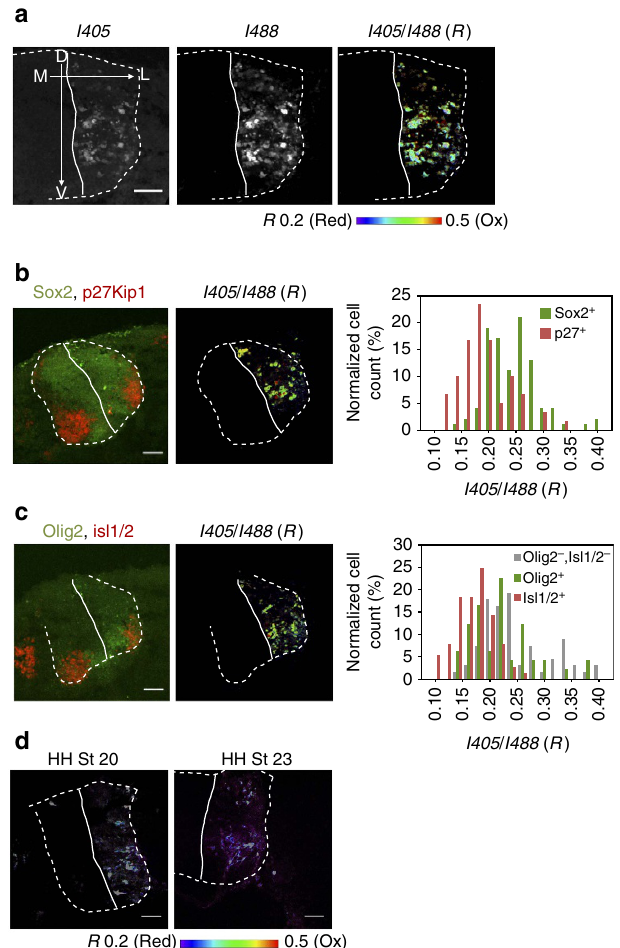
Figure 3 | Redox status of cytosolic glutathione within neurons of chicken spinal cord. ( a ) Representative Grx1-roGFP2 image illustrates variation of redox states in neuronal cell population within a spinal cord. The R values (0.20–0.50) are shown with the pseudo-colour scale that corresponds to 0 to 29% oxidation of the sensor. Scale bars, 50 m m. ( b ) Distribution of R values in different cell populations. The sections were stained for Sox2 and p27Kip1 which define the regions of actively cycling cells (Sox2 þ ) and differentiated cells (p27Kip1). Scale bar, 50 m m. (higher magnification is shown in Supplementary Fig. 9a). The ratio I405/I488 ( R value) for Sox2 þ (0.24 ± 0.06; n ¼ 102) is significantly higher than in p27Kip1 þ (0.18 ± 0.05, n ¼ 60) regions (Student’s t -test, P o 0.001). ( c ) The sections were stained for Olig2 and Isl1/2 which define cycling motor neuron progenitors and postmitotic motor neurons, respectively. Scale bar, 50 m m. The R values for Olig2 (cid:2) :Isl1/2 (cid:2) (0.25 ± 0.07; n ¼ 68), Olig2 þ :Isl1/2 (cid:2) (0.23 ± 0.09, n ¼ 49) and Olig2 (cid:2) :Isl1/2 þ (0.16 ± 0.03, n ¼ 77) regions. See Supplementary Fig. 9b for magnified view. Differences between Olig2 (cid:2) /Isl1/2 þ from other regions are significant at P o 0.001. There is no statistically significant difference between Olig2 (cid:2) :Isl1/2 (cid:2) and Olig2 þ :Isl1/2 (cid:2) regions ( P ¼ 0.06). ( d ) Cytosolic glutathione in neuronal cells is more reduced in embryos at the later development stage. Embryos at HH stage 23 were compared with the stage 20 embryos (see Supplementary Fig. 8b and c for full information). Scale bar, 50 m